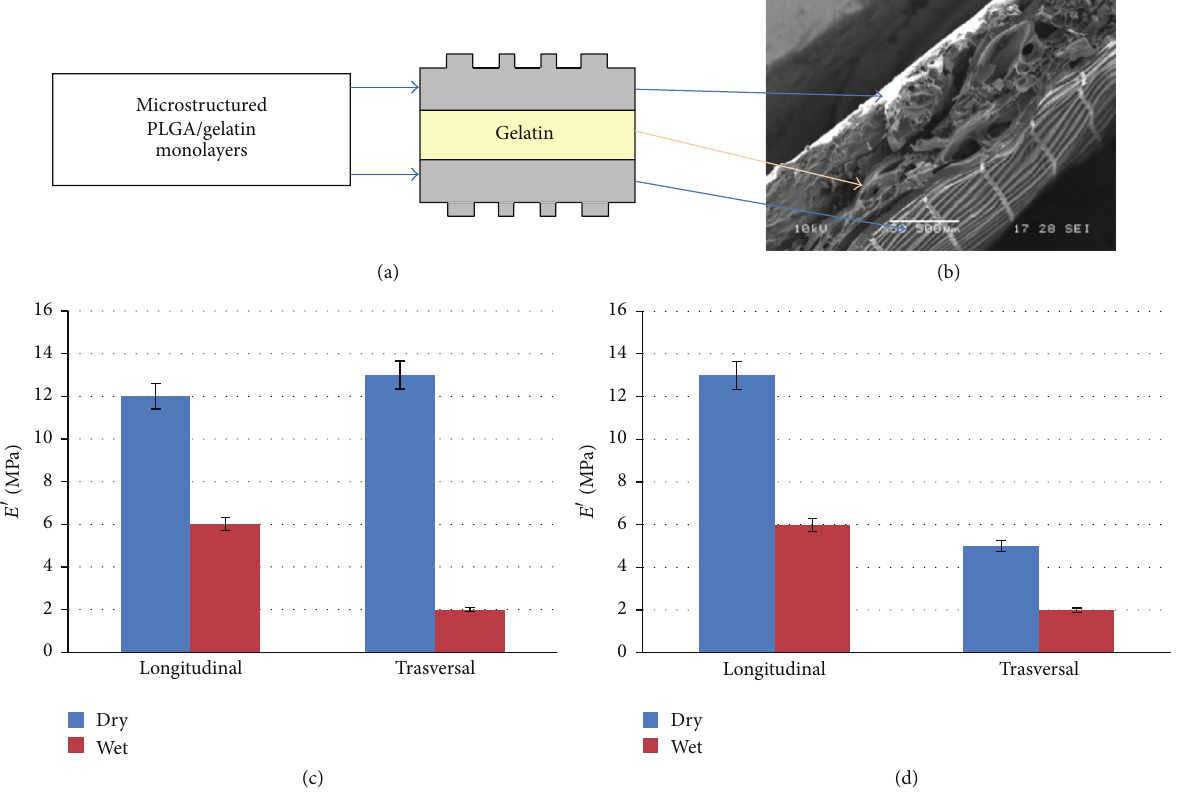
Figure 4: Schematic drawing (a) and SEM image (b) of a section of microstructured PLGA/gelatin 70/30 bilayer; mechanical behavior of microstructured PLGA/gelatin 70/30 monolayer (c) and bilayer (d) scaffold.